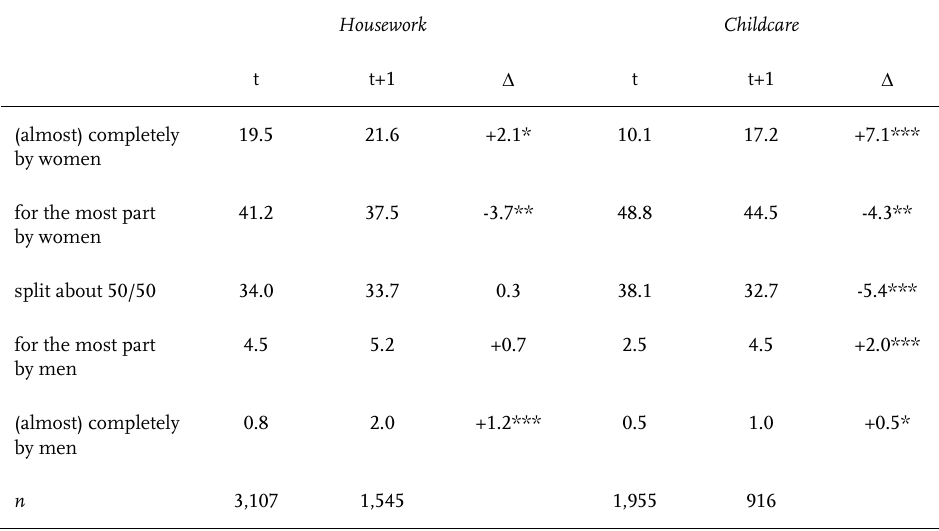
Table 1 : The division of housework and childcare before (t) and during (t+1) the Corona crisis – proportions and changes at the aggregate-level (in